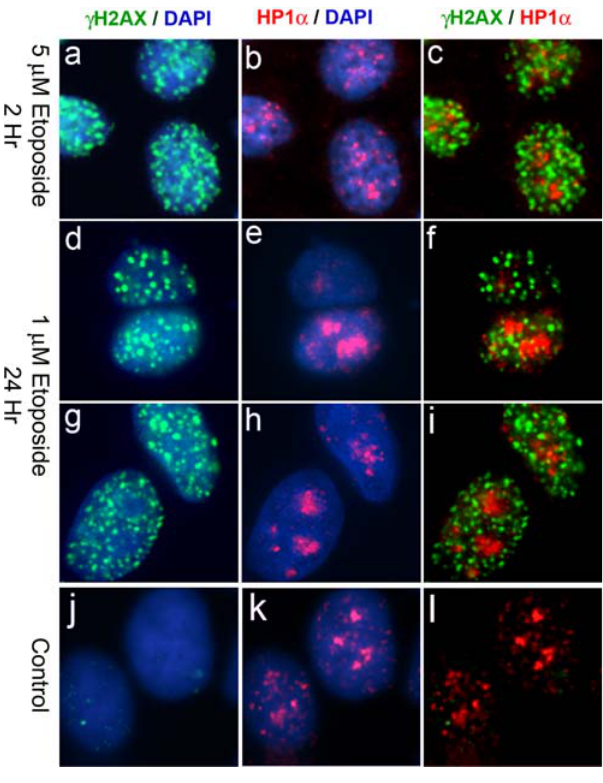
Figure 2. c H2AX foci generated by etoposide treatment do not appear in HP1 a -staining regions in MCF7 cells. MCF7 cells were incubated in medium containing etoposide and processed as in Figure 1. Panels a–c, two hour exposure to 5 m M etoposide. Panels d–i, 24 hour exposure to 1 m M etoposide. Panels j–l, untreated cells. Cells were fixed immediately after etoposide treatment.